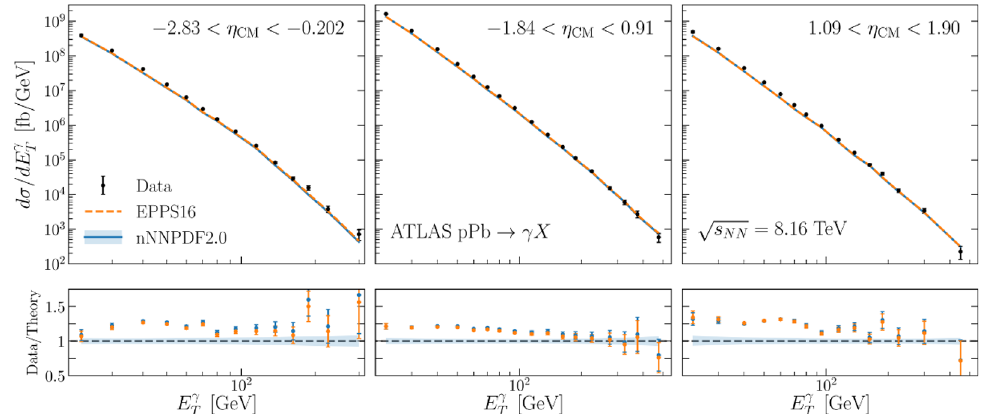
Figure 22 . Comparison between the ATLAS measurements of the photon E (cid:13) rapidity bins in the center of mass frame with the corresponding NLO QCD theory calculations based on MCFM with nNNPDF2.0 and EPPS16 as input. For each rapidity bin, the upper panels display the absolute distributions and the lower panels the corresponding ratio between the theory calculations and the central value of the experimental